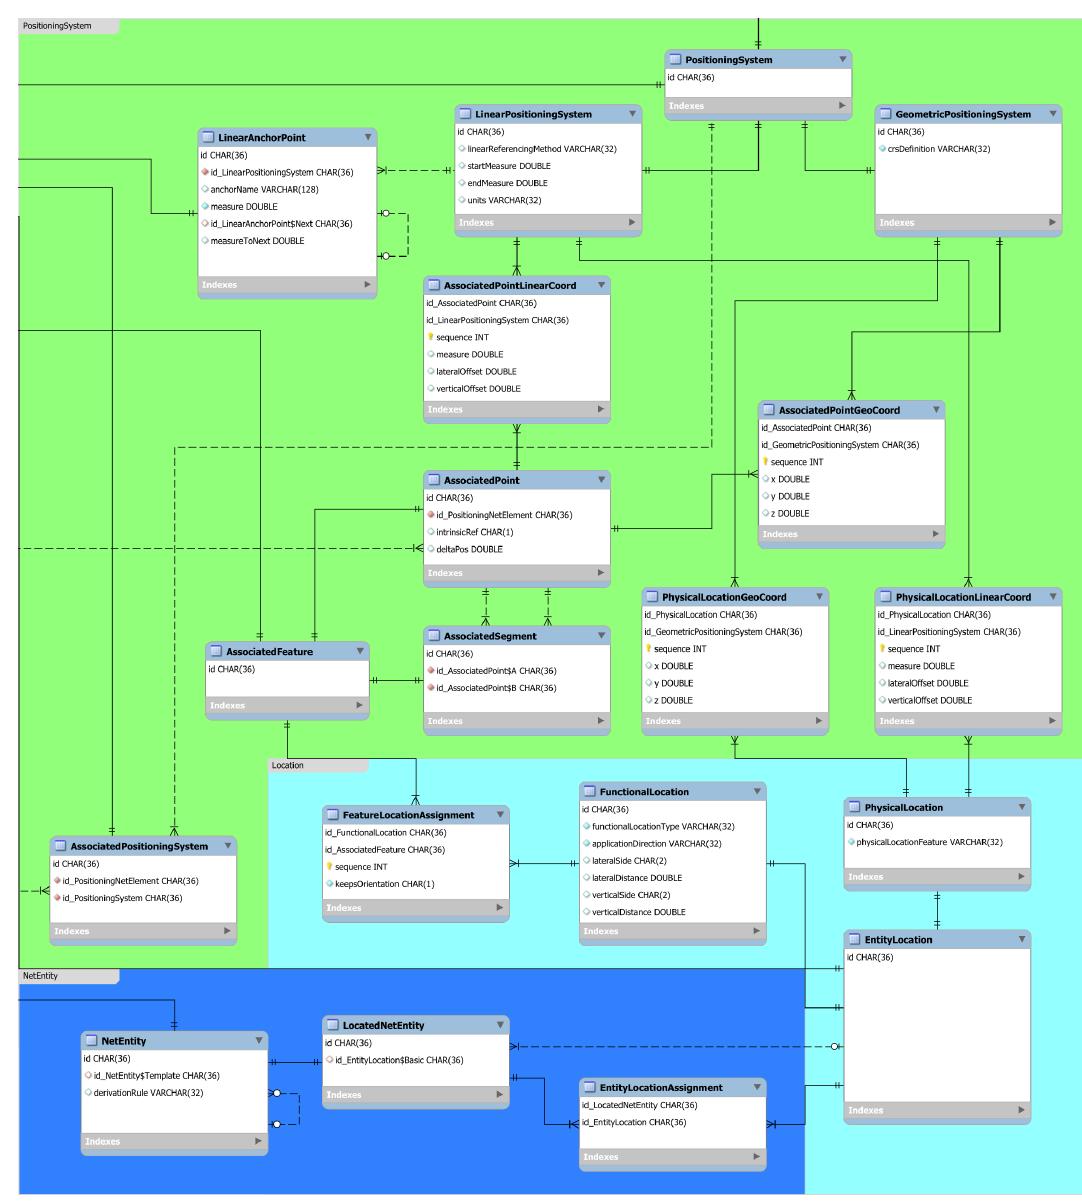
Figure 3. The positioning system, net entity and location modules of the Multipurpose Railway Infrastructure